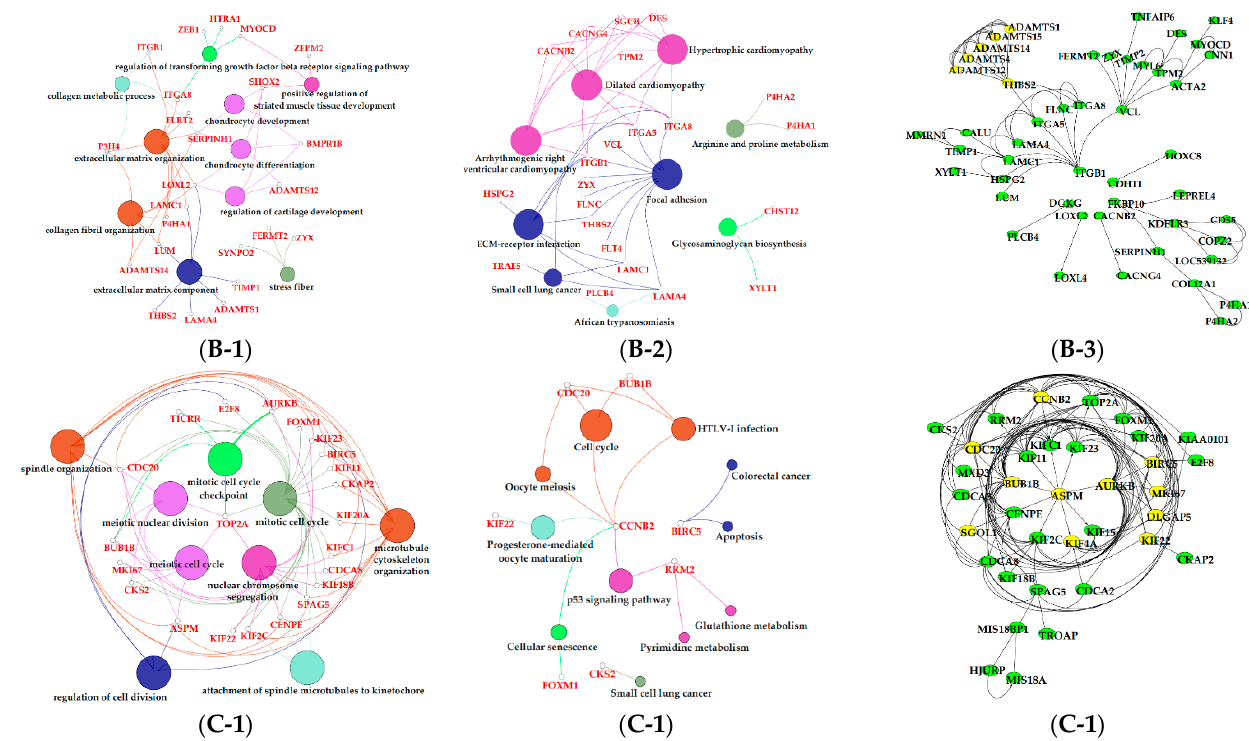
Figure 7. Functional analysis of genes in bule, brown and purple modules. Gene ontology (GO) analysis of genes in bule ( A-1 ), brown ( B-2 ) and purple ( C-1 ) modules. Kyoto Encyclopedia of Genes and Genomes (KEGG) pathway analysis of genes in bule ( A-2 ), brown ( B-2 ) and purple ( C-2 ) modules. The significant GO terms and KEGG pathways were visualized using Cytoscape software based on network analysis of ClueGO/CluePedia inferred from MCODE clusters. The size of nodes indicated the p -value. The color of nodes represented the functional group that they belonged to. The names of important pathways were in black bold characters. The protein–protein interaction (PPI) networks showed the interactions of genes in the bule ( A-3 ), brown ( B-3 ) and purple ( C-3 ) modules, respectively. Each node represented a gene and the yellow nodes expressed the key genes in each module.